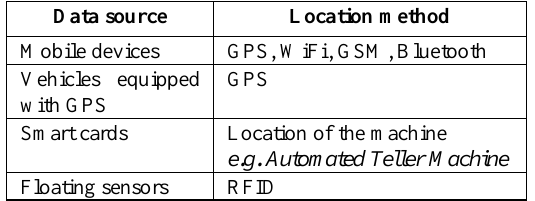
Table 1 . Data source and relating collection methods Data storage